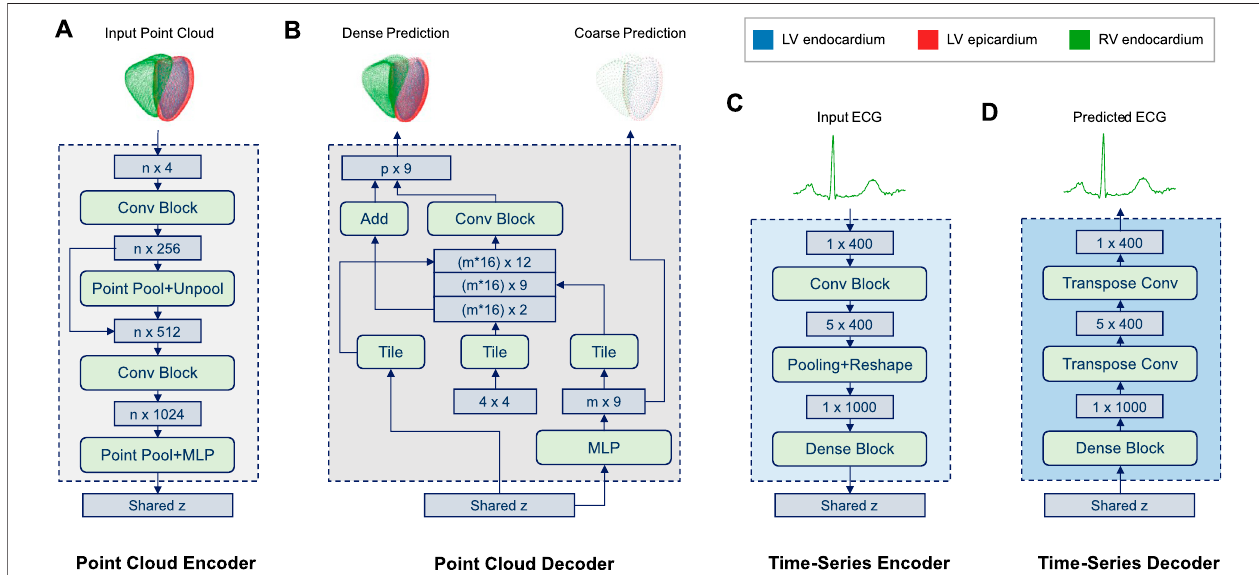
FIGURE 2 | Overview of the encoder and decoder architectures of both the point cloud (A,B) and time series (C,D) branches of the multi-domain VAE. The input pointcloud (A) encodesthebiventricularanatomyasaset(n=36,000)of4Dvectors(x,y,zcoordinatesandtheclasslabelofeachpoint),whileaseparatesetof3Dpoint coordinatesisusedforeachofthethreecardiac substructuresintheoutputpointcloud (B) .Thepointclouddecoder (B) outputsboth acoarse,low-dimensional(2,250 points) and a dense, high-dimensional (36,000 points) representation of the cardiac anatomy. The former represents the fi nal output used for further processing, while the latter primarily facilitates the training process in this work ( Eq. 5 ) by fi rst focusing on an approximate reconstruction and later putting more emphasis on the dense output. Both input and output ECG time series (C,D) are represented as 400-dimensional vectors. Both encoders (A,C) are tasked with predicting the shared latent space z . The time-series decoder (D) follows a symmetric design to its encoder (C) and aims to reconstruct the input ECG signal from the latent space during training. (Background colors of architecture blocks are consistent with Figure 1 )